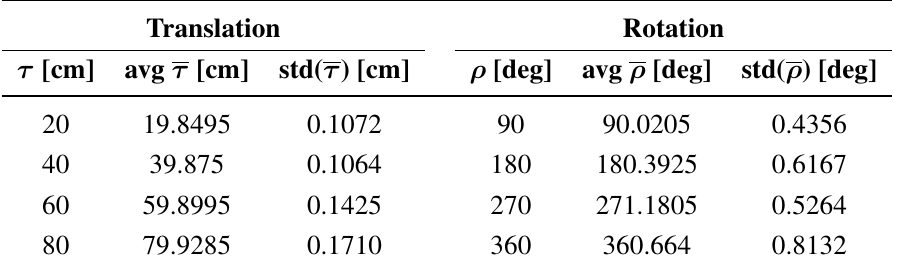
Table 1. Test results for head translation and rotation by